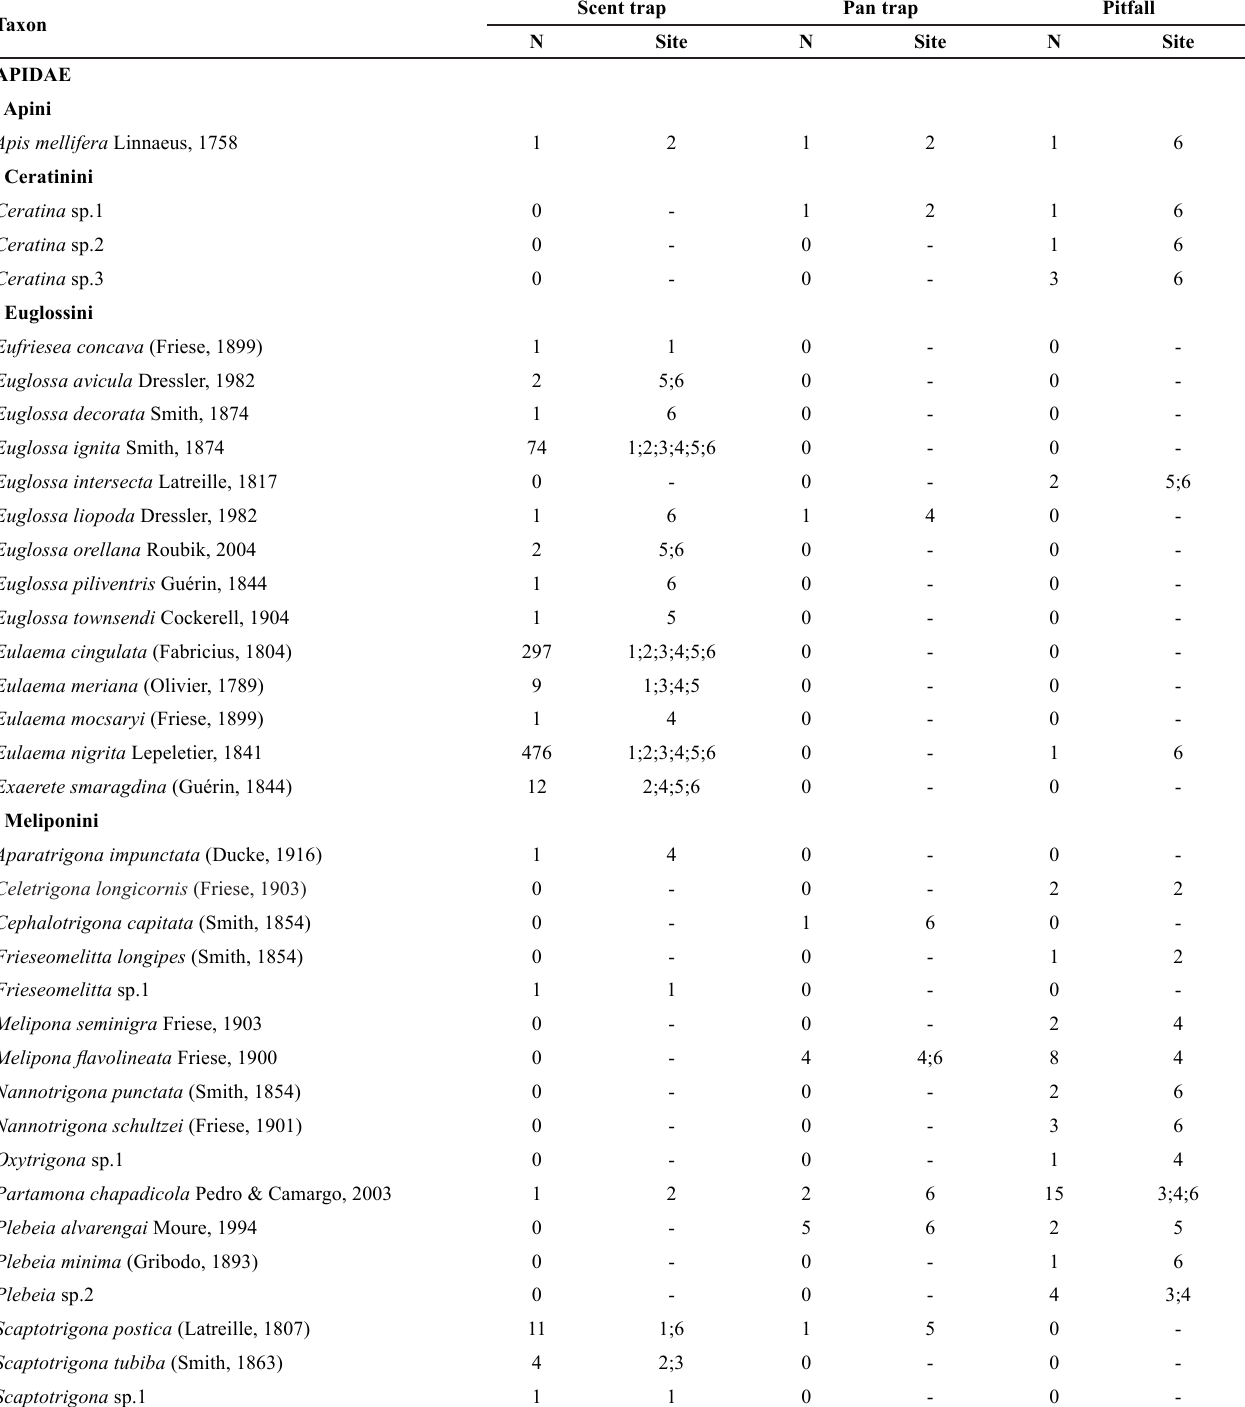
Table 1 . List of bee species sampled in six sites and using three different traps (arboreal pitfalls with urine, scent trap and pan traps) in a Cerrado and Amazon Forest ecotone in the municipality of Conceição do Araguaia, southeast of Pará, Brazil. (N = Abundance of